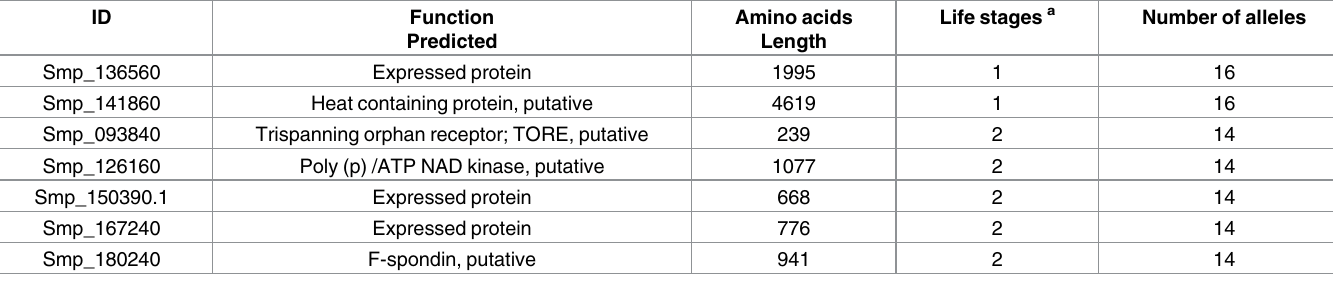
Table 1. Schistosoma mansoni proteins selectedafter in silico analysis, according to the strategy outlined in the workflow.